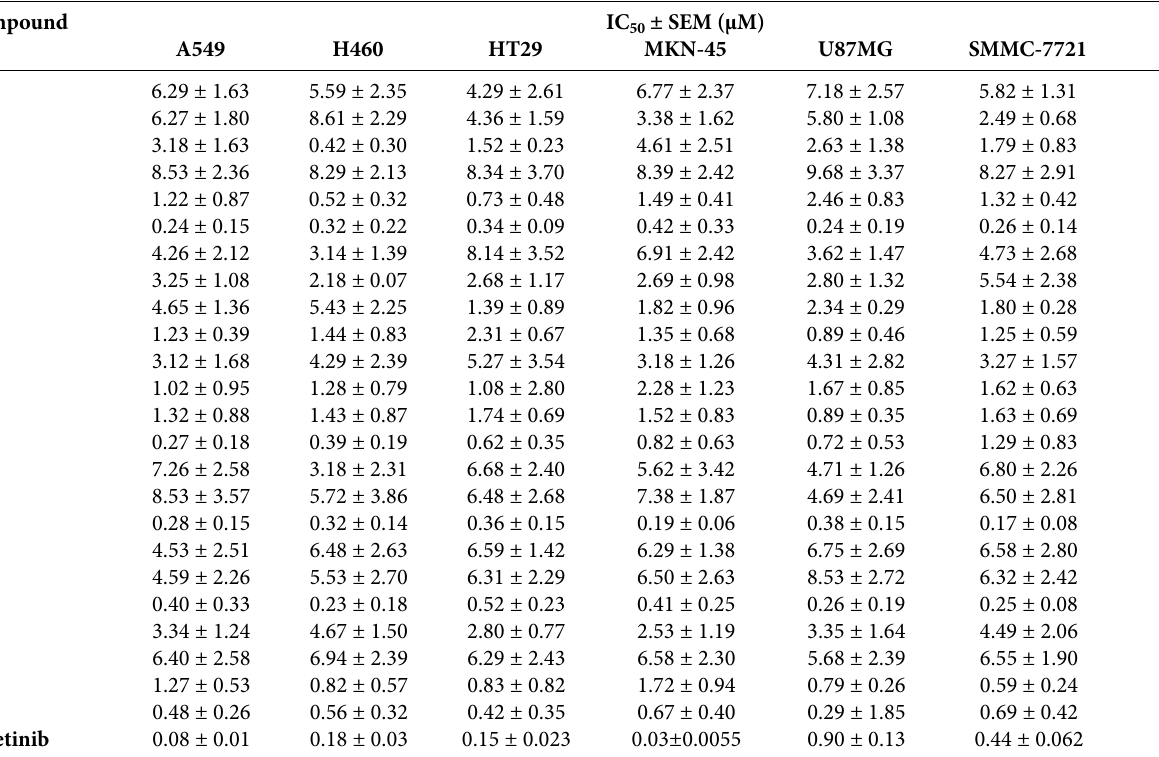
Table 1 . In vitro growth inhibitory effects IC 50 ± SEM (µM) of the newly synthesized compounds against cancer cell lines.